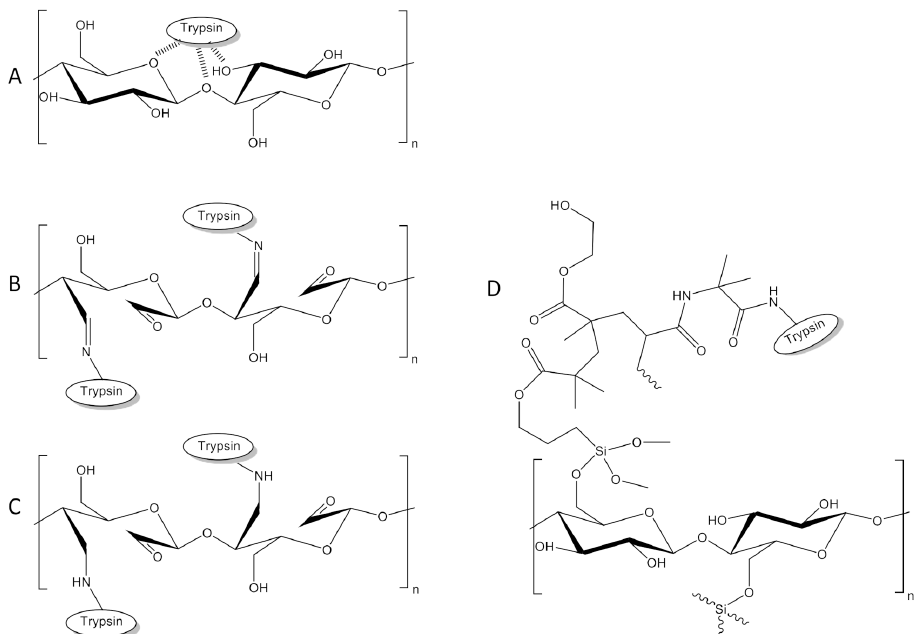
Figure 2. Binding of trypsin to cellulose ( A ) without treatment, ( B ) after KIO 4 oxidation ( C ) after KIO 4 oxidation and NaCNBrH 3 reduction ( D ) after HEMA-VDM silanization and